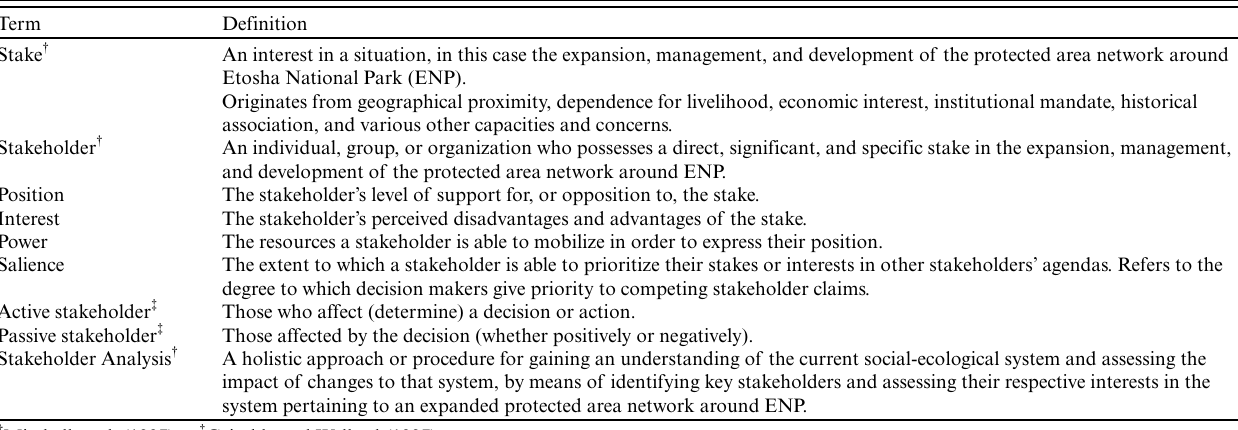
Table 1 . Explanation of key terms used in the